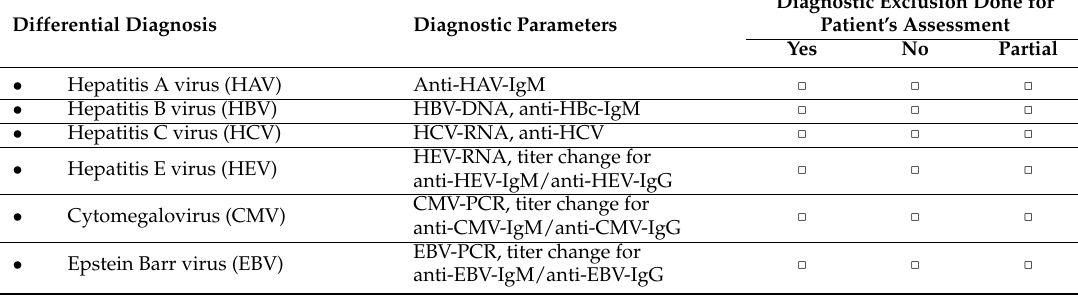
Table 4. Checklist of differential diagnoses of DILI and HILI. This tabular listing, although not comprehensive, is to be used as a guide and in connection with the updated RUCAM (Tables 2 and 3), derived from a previous publication